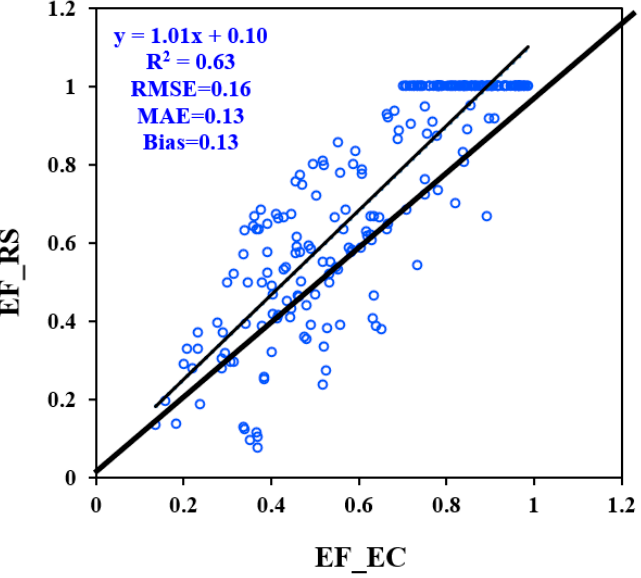
Figure 9. Scatters of the EF estimates against in situ measurements, where EF: Evaporation fraction, RS: data derived from remote sensing; EC: data observed from eddy covariance.